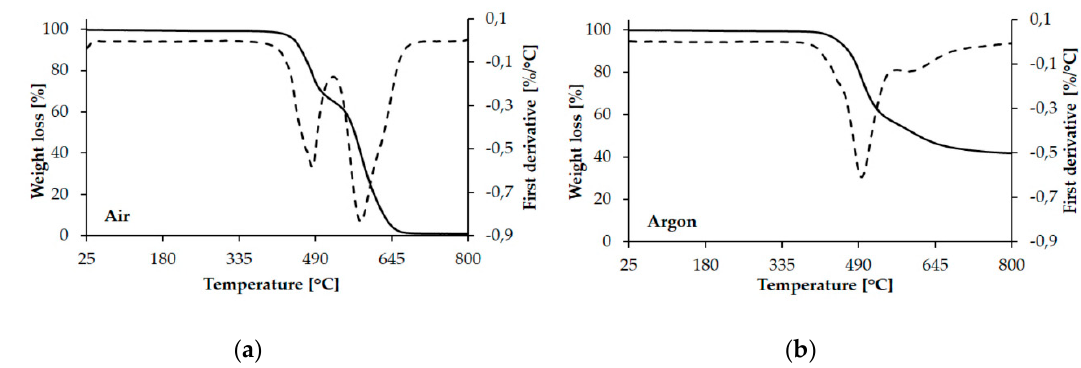
Figure 3. TGA (continuous lines) and D-TGA (dotted lines) curves for Ultem 9085 under ( a ) air and ( b ) argon atmosphere.